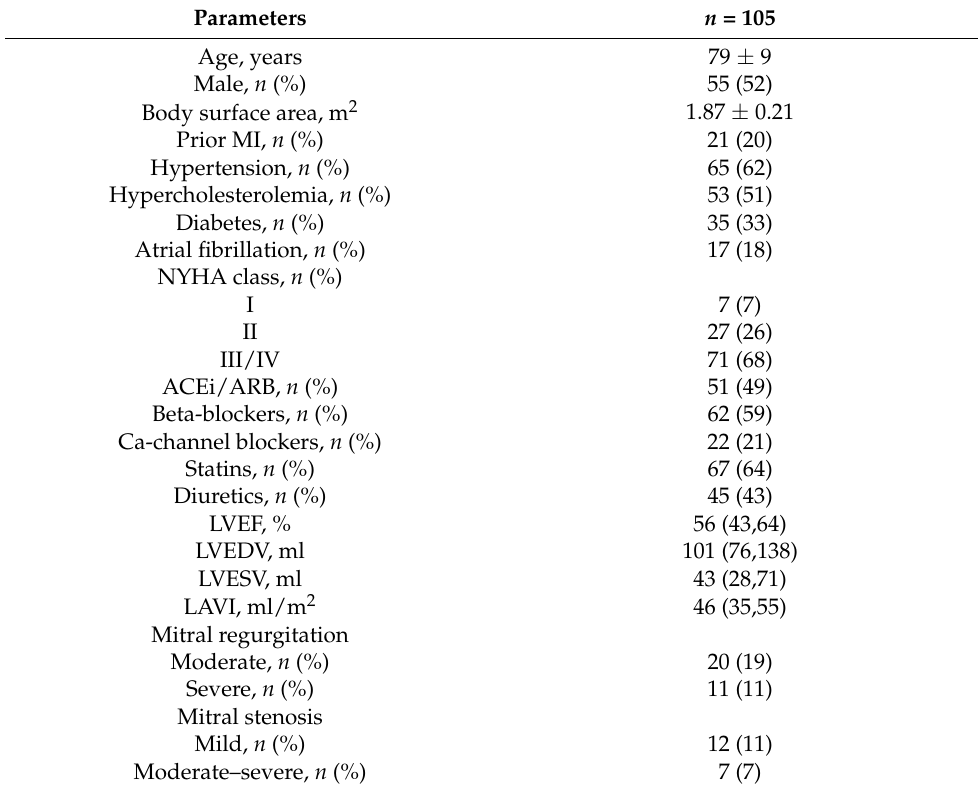
Table 1. Patients’ demographic and clinical